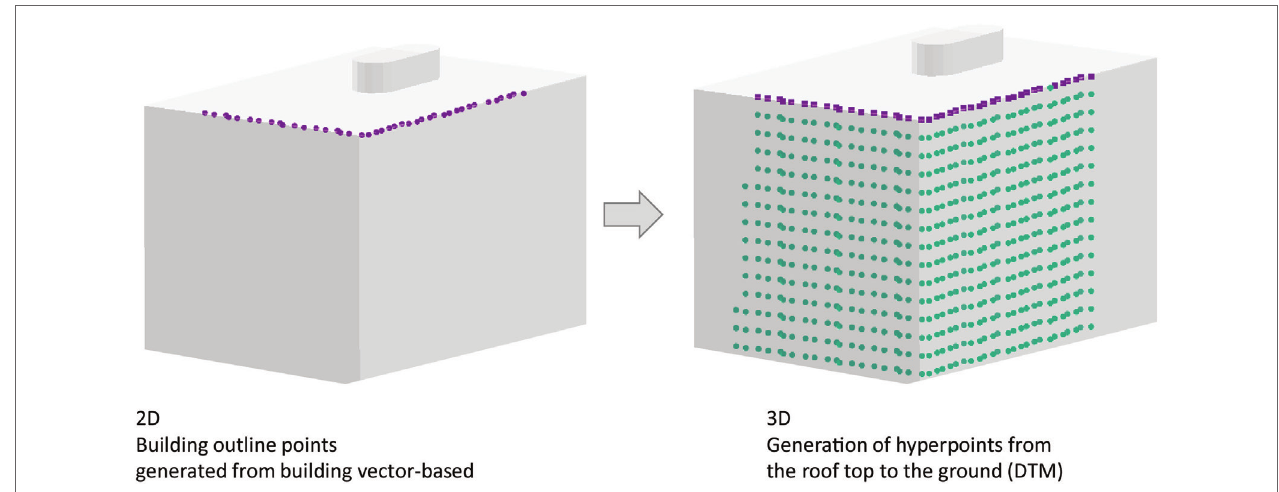
FIGURe 2 | Generation of facades’ “hyperpoints” using 2D vector data of building